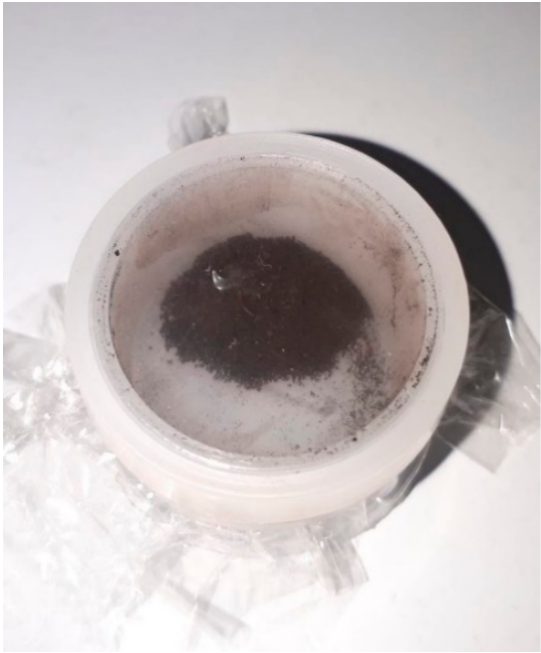
Figure 6. Total sediment of the fuel composition.